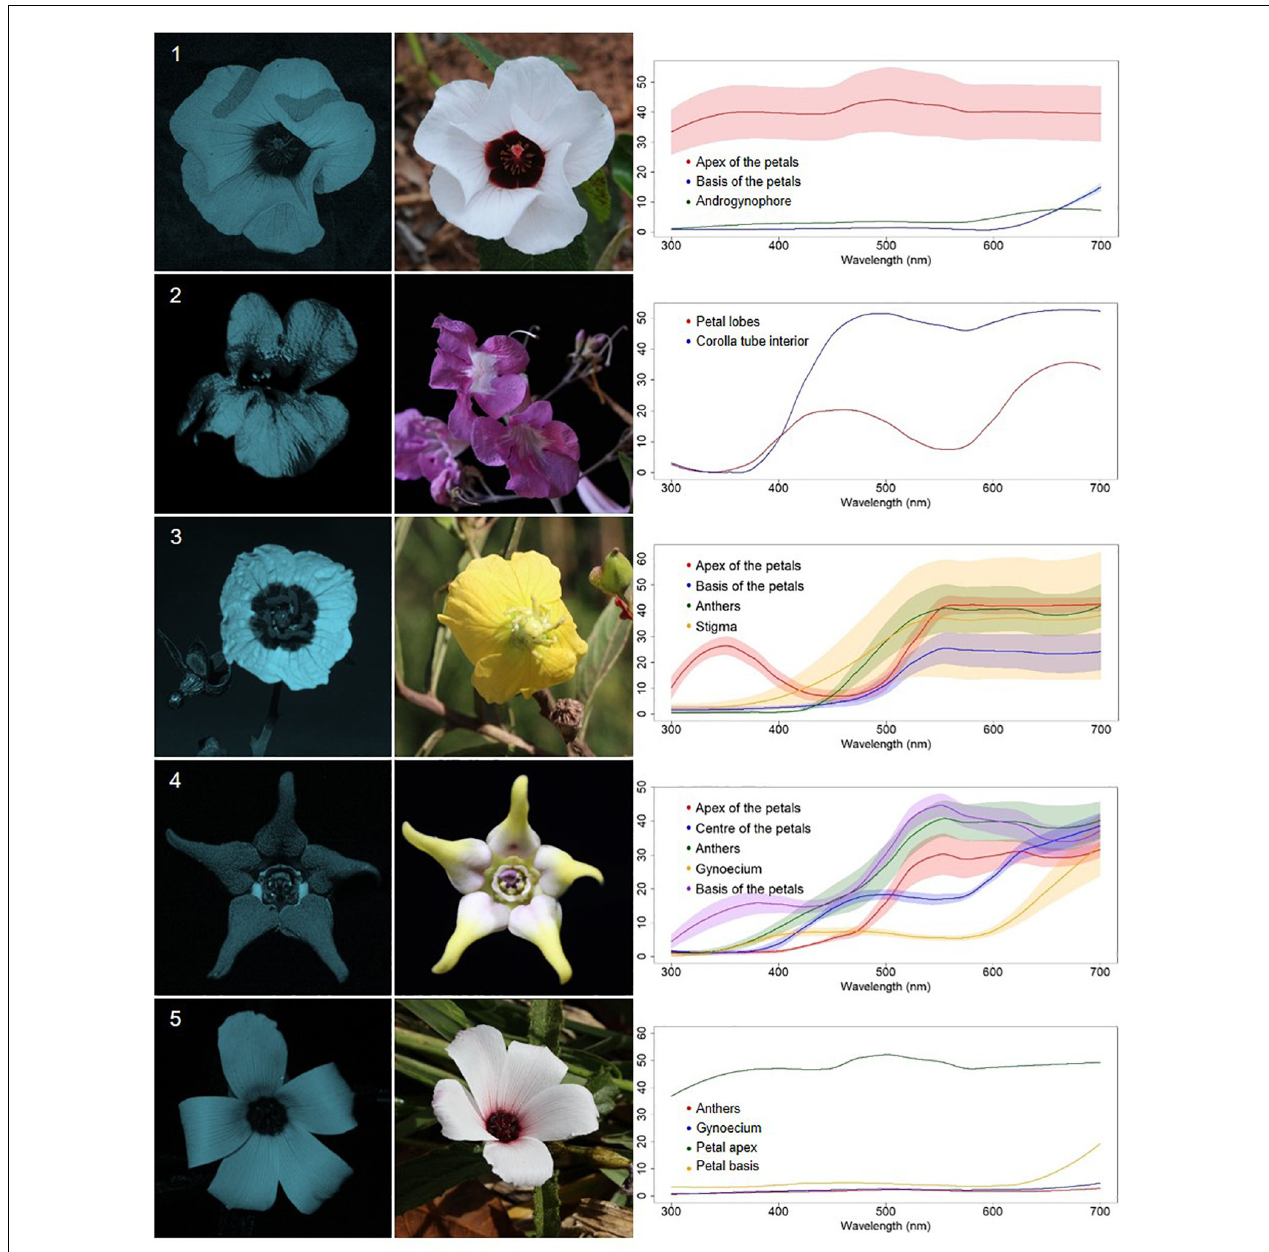
FIGURE 3 | Bullseye UV-patterned flowers (BE) from a Neotropical savanna community. Each row comprises information of one species. First column: UV-photography. Second column: flower as seen by the human eye (conventional photography). Third column: reflectance curves of different portions of the flowers. Row 1. Peltaea polymorpha (A. St.-Hil.) Krapov. and Cristóbal (Malvaceae). Row 2. Cuspidaria sp. (Bignoniaceae). Row 3. Ludwigia nervosa (Poir.) H.Hara (Onagraceae). Row 4. Oxypetalum appendiculatum Mart. (Apocynaceae). Row 5. Piriqueta aurea (Cambess.) Urb.